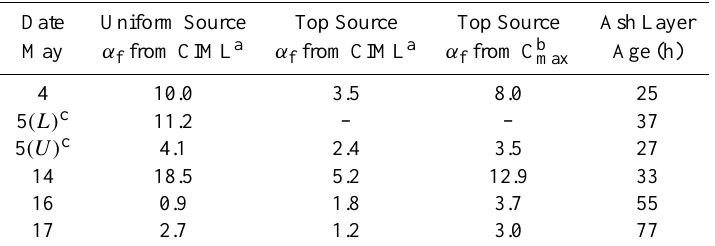
Table 1. Estimates of distal fine ash fraction, α f (%).